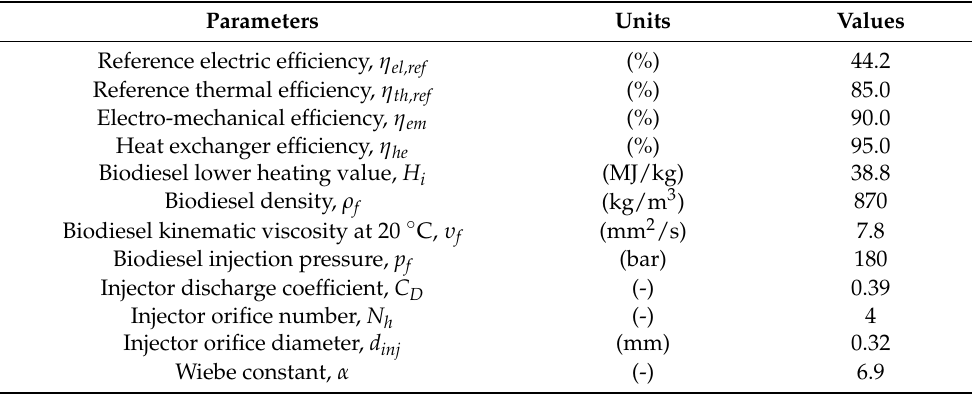
Table 2. Operating conditions and main